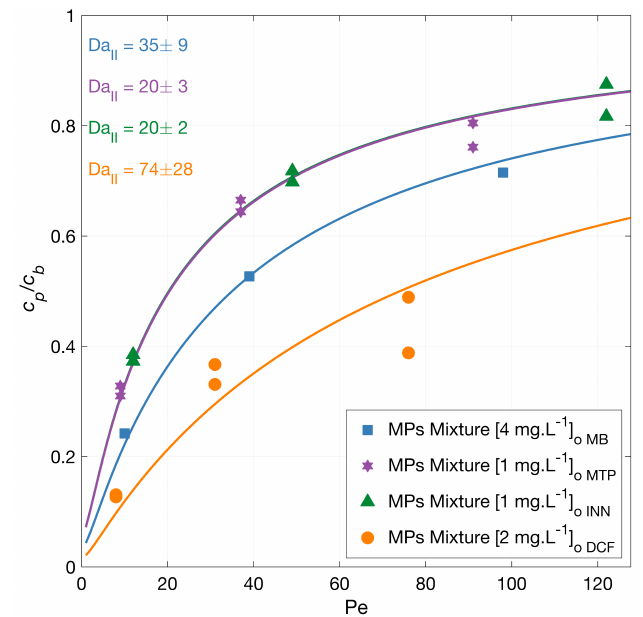
Figure 3. MPs mixture degradation vs. filtration rate. Symbols depict experimental data of the MPs in a mixture, and the lines correspond to the mass transport and surface reaction model. The experiments were carried out with the MPs in a mixture,. The legend shows the feed concentrations [ c b ] o